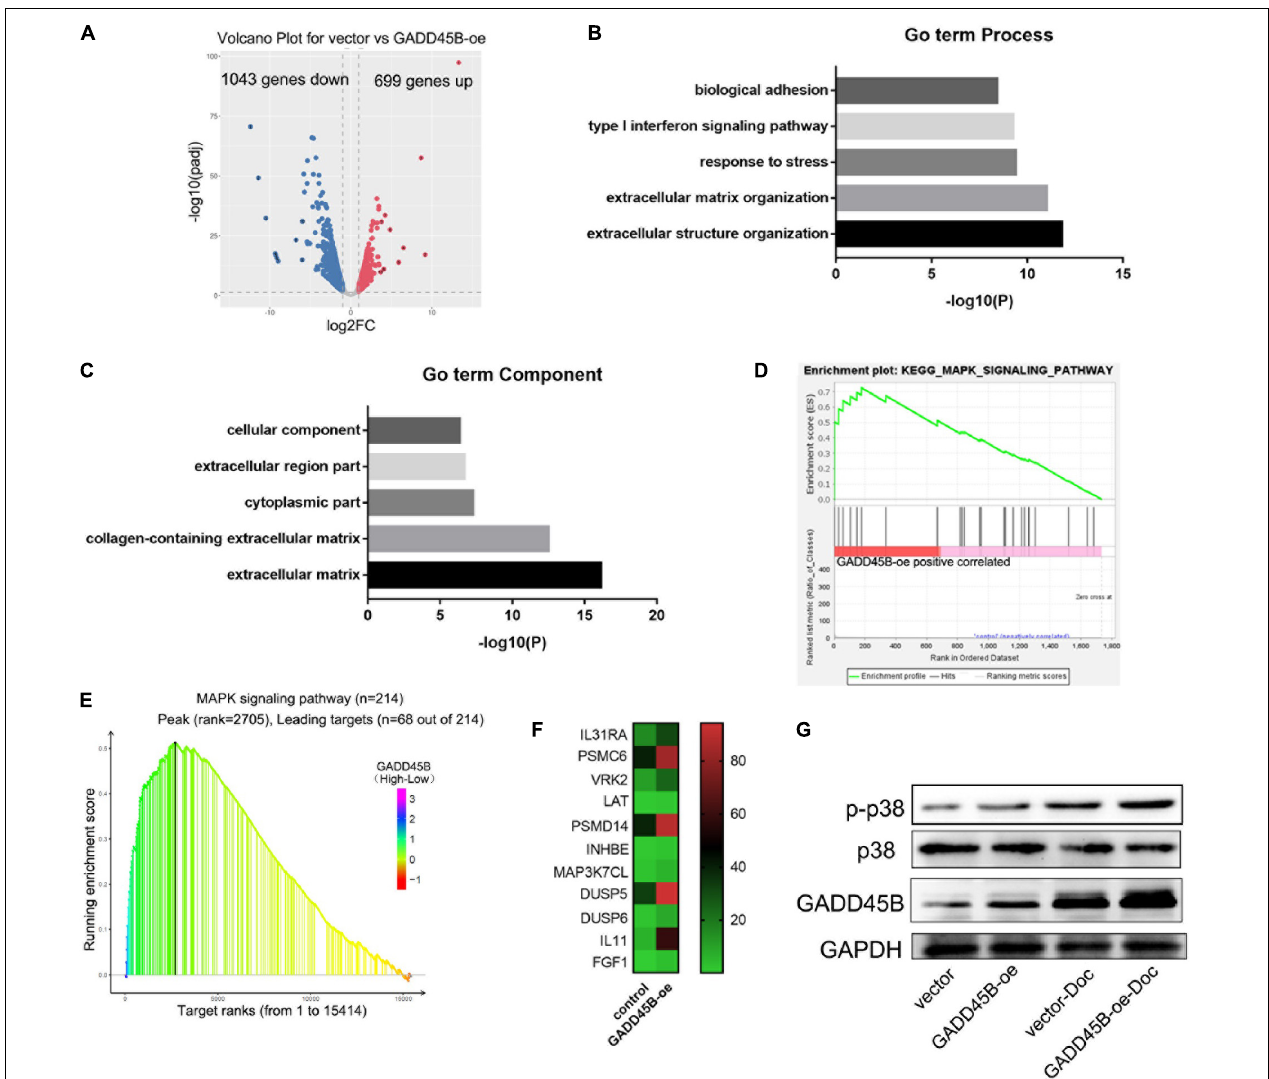
FIGURE 7 | GADD45B regulated cell apoptosis through the p38/MAPK pathway. (A) Volcano map of differentially expressed genes in GADD45B overexpression group. (B,C) GO term analysis of differentially expressed genes in GADD45B overexpressed cells. (D) GSEA analysis of differentially expressed genes in GADD45B overexpressed cells. (E) GSEA analysis of GADD45B in TCGA. (F) Heatmap of MAPK pathway–related genes when GADD45B overexpressed. (G) Representative image of the WB of GADD45B, p38 and phosphorylated p38 protein levels before and 48 h after chemotherapy in DU145